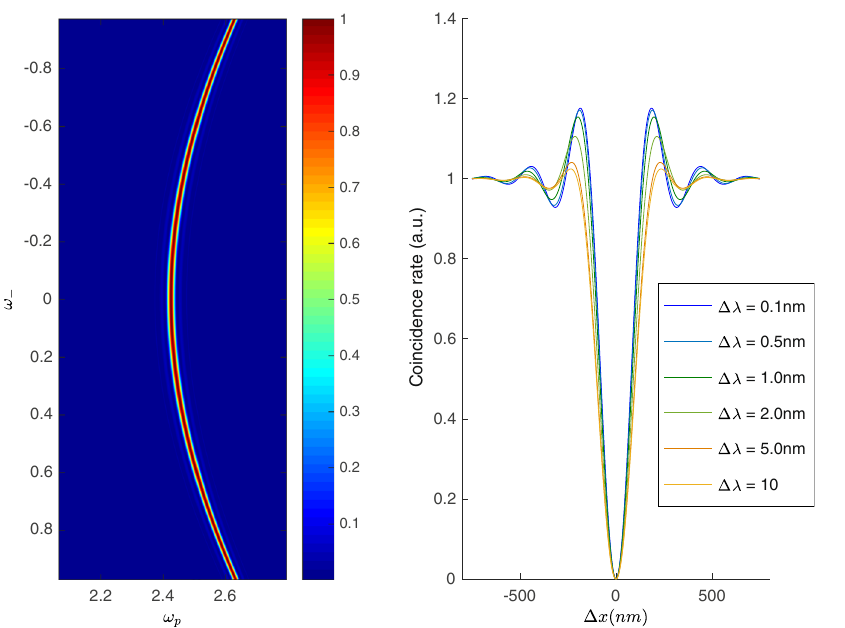
Figure 4. Left: the phase matching function φ 2 , as a function of ω p = ω 1 + ω 2 , and ω _ = ω 1 − ω 2 for non- collinear type I. Right: HOM coincidence pattern as a function of the delay Δ x = c τ , for different pump bandwidths, measured as the FWHM of a Gaussian profile. The count rate is normalised so to be 1 in the absence of interference, for long delays. Both panels refer to the case for a 2-mm bismuth borate (BiBO) crystal, phase matched for 775 nm → 1550 nm conversion at an angle 9° with respect to the pump